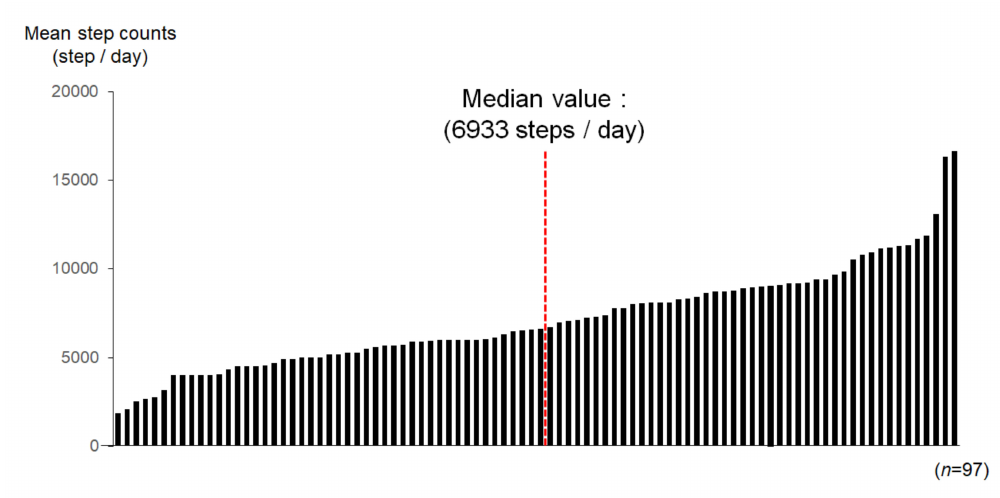
Figure 2. Physical activity in each patient assessed during the outpatient clinic